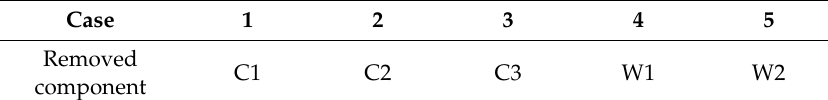
Table 8. Progressive analysis cases.